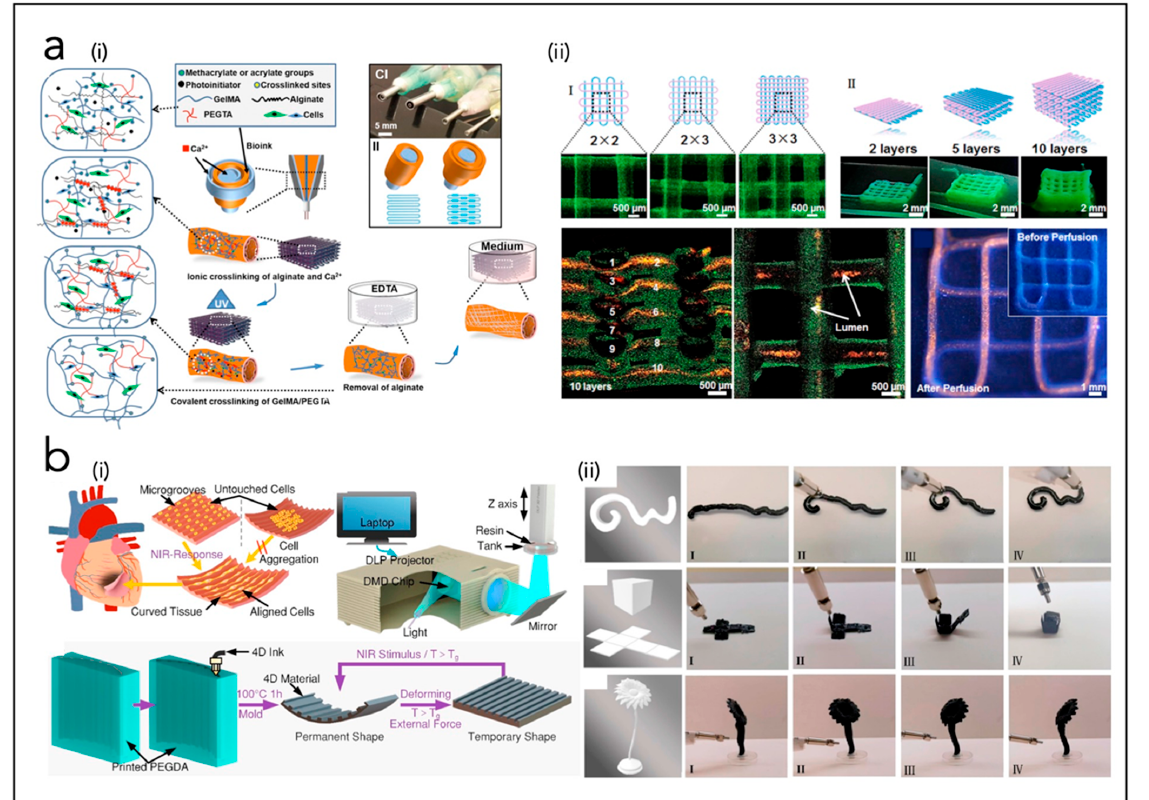
Figure 11. Examples of 3D/4D bioprinted cardiac tissues. ( a ) Crosslinking processes of bioinks based on alginate, GelMA, and PEGTA, ionically and covalently crosslinked upon exposure to CaCl 2 solution and UV light (i) for 3D bioprinting of perfusable tubular constructs (ii). Adapted with permission from reference [244], 2016 Copyright, Elsevier. ( b ) 4D printed cardiac patch with aligned myofibers and adjustable curvature for myocardial regeneration (i). Continuous imaging of 4D printed structures at subsequent time steps (I, II, III, IV) (ii). Reprinted with permission from reference [251], 2021 Copyright, American Chemical